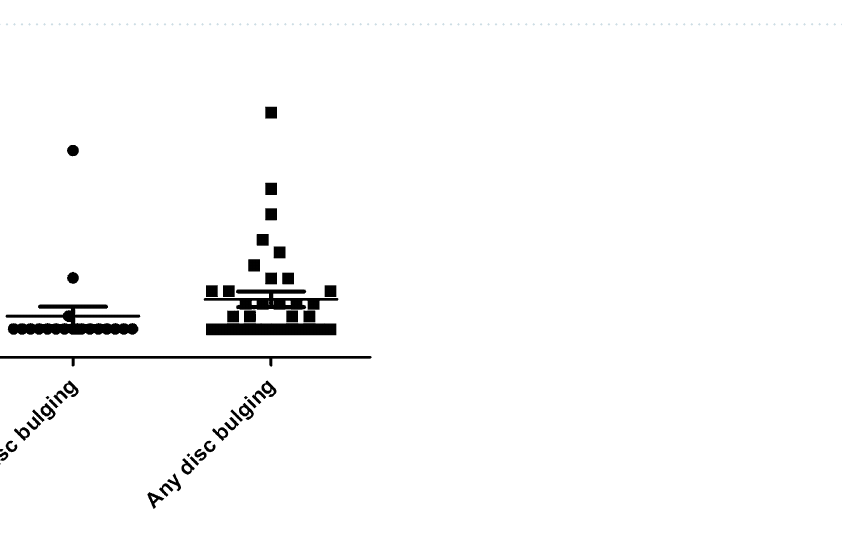
Figure 3. The Roland ‐ Morris Disability Questionnaire score in subjects with and without lumbar disc